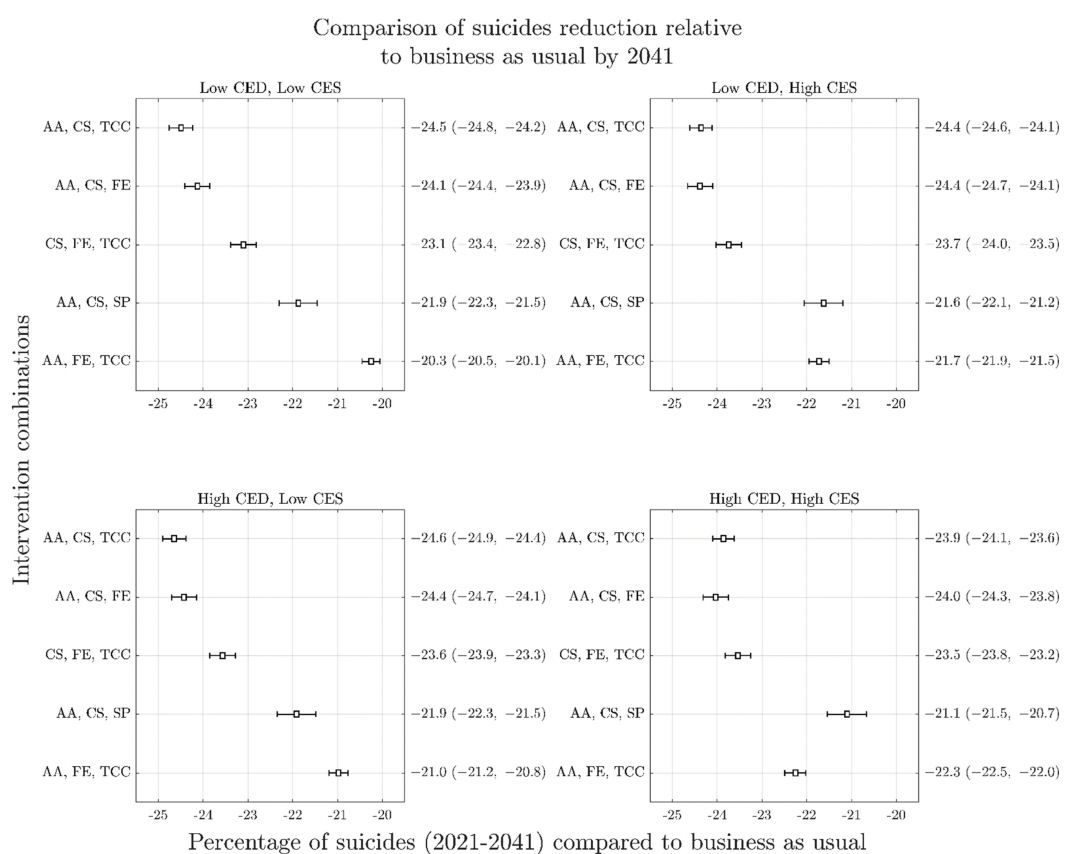
Figure 3. Forest plots arising from sensitivity analyses of reduction in cumulative suicide deaths (2021–2041) as a result of top performing intervention combinations across the four COVID-19 mental health scenarios. Panels represent different COVID-19 scenarios: top left, short duration and low impact (Scenario A); top right, short duration and high impact (Scenario B); bottom left, long duration and low impact (Scenario C); bottom right; long duration and high impact (Scenario D). The y -axis of each panel presents the mean percent reduction in cumulative suicides against the baseline (business as usual) for each intervention combination with uncertainty intervals in brackets. Overlapping 95% intervals indicate possible ambiguity of rankings within each COVID-19 mental health scenario, relating to the uncertainty in intervention effect sizes and services capacity growth rates. Similarity of possible rankings between scenarios is indicative that uncertainty about the effects of COVID-19 on mental health do not change recommendations about optimal intervention investments. AA is post-suicide attempt aftercare; CS is community support programs to